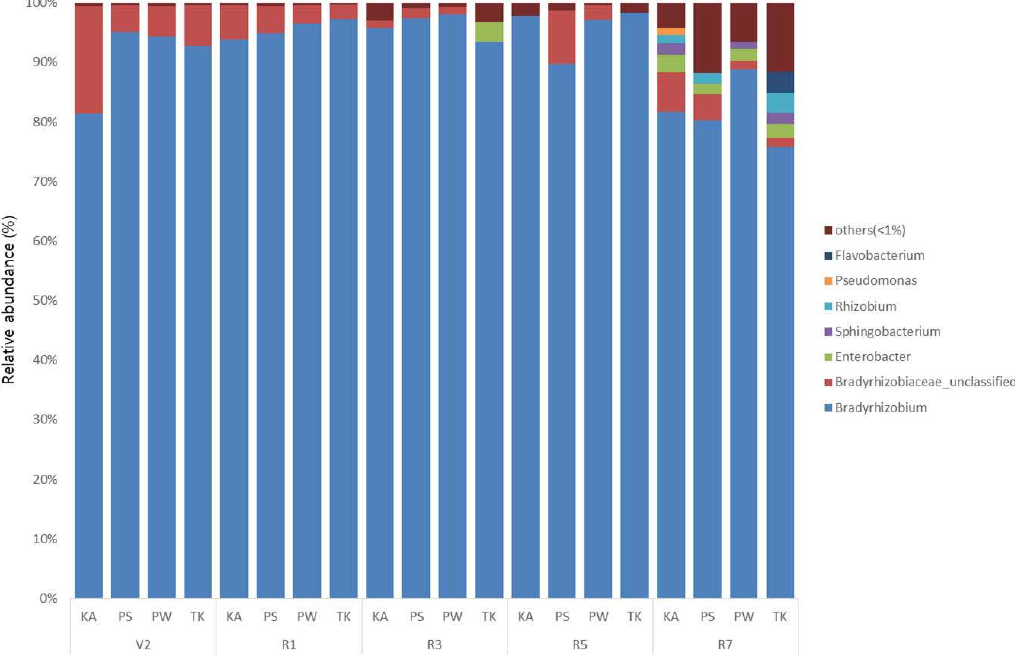
Figure 6. Relative abundance of genus in root nodule based on the growth stages (V2, R1, R3, R5, R7) of soybean. A, B. The bacterial community structure in the bulk soil was different from other growth stages and the stages V2, R1, R3, and R5 of the rhizosphere soil were clustered together; however, the R7 stage is also different from those of other growth stages. These results indicate that after planting the bacterial communities in the soil differed compared to those of bulk soil. Moreover, among the different growth stages the bacterial community composition at the R7 has been differed